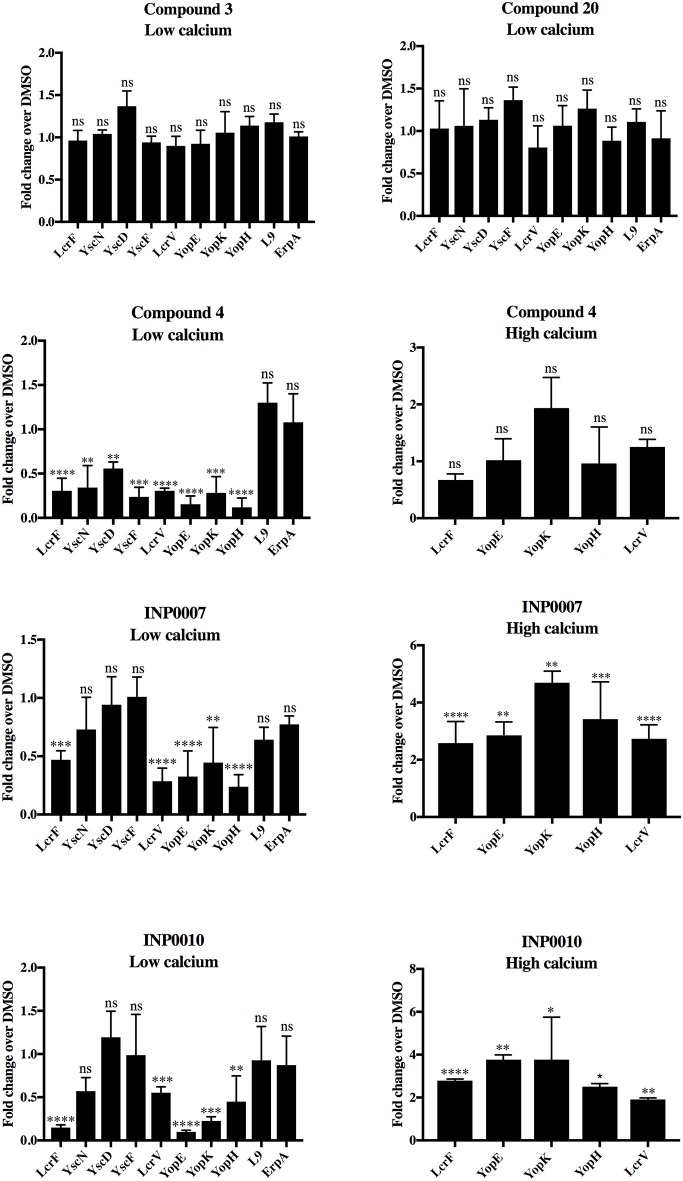
T3SS gene mRNA levels under low and high calcium conditions. Wildtype Y. pseudotuberculosis was grown under high or low calcium conditions in the presence of 50 μM compound or equivalent volume of DMSO and mRNA levels of T3SS (lcrF, yscN, yscD, yscF, lcrV, yopE, yopK, yopH) and non-T3SS genes (L9, erpA) assessed by qPCR. The average of four biological replicates ± standard deviation is shown and statistical significance is represented comparing compounds relative to the DMSO control for each gene. ****P < 0.0001, ***P < 0.0005, **P < 0.003; *P < 0.022 (one way ANOVA with Dunnett's post-hoc test). ns, not significant.